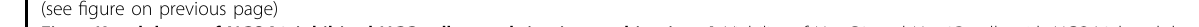
Fig. 4 Knockdown of NCOA3 inhibited HCC cell growth in vitro and in vivo. A Viability of HepG2 and Hep3B cells with NCOA3 knockdown. B The colony formation ability of HepG2 and Hep3B cells with NCOA3 knockdown. C Nude mice were subcutaneously injected with Hep3B cells with nonspeci fi c shRNA (sh-Ctrol), NCOA3-speci fi c shRNAs (sh-N3-04, sh-N3-05), sh-N3-04 + vector, or sh-N3-04 + TERT overexpressing plasmid (TERT). Images of the HCC tumor xenograft from each mouse (n = 5 mice/group) were captured, tumor volumes were recorded every 4 days, tumor weights were analyzed, D the expression of NCOA3 and TERT in tumor tissues were detected by IHC staining, and mouse body weights were monitored ( E ). F mRNA levels of the Notch target genes (HES1, HES6, HEY1, and NRARP), Wnt target genes (MYC, TCF-1, and CCND1), and NCOA3 in Hep3B cells with NCOA3 knockdown were measured by RT-qPCR. The data were shown as means ± SD, * P < 0.05, ** P < 0.01. *** P < 0.001, # P < 0.05, ## P < 0.01, Student ’ s t test.